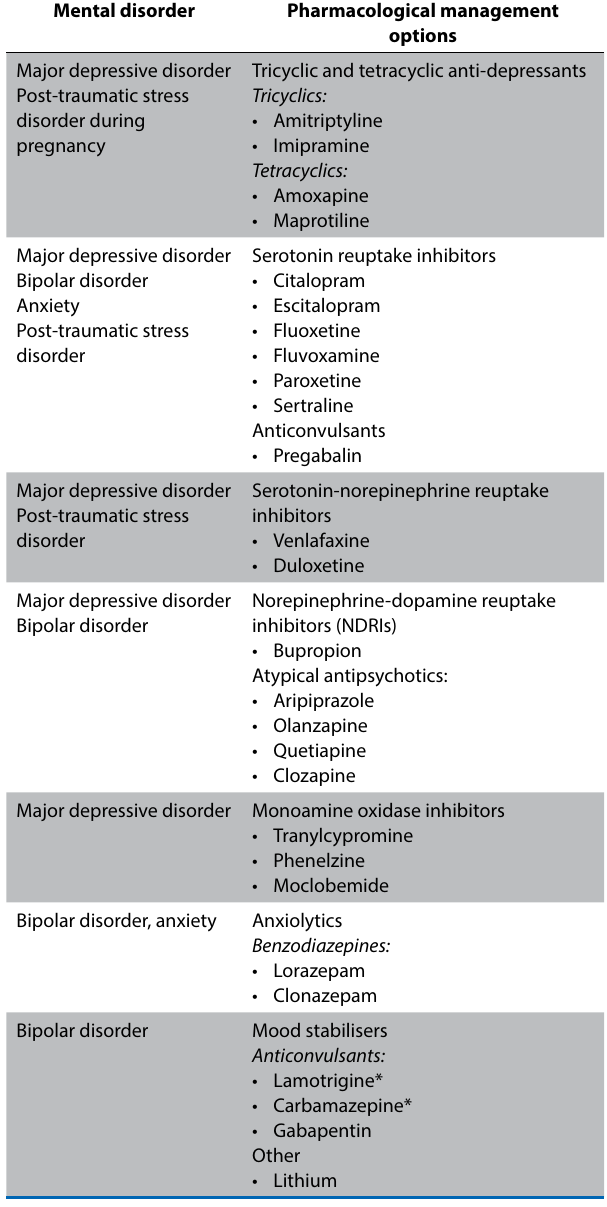
Table I. Summary of pharmacological treatment options for mental disorders